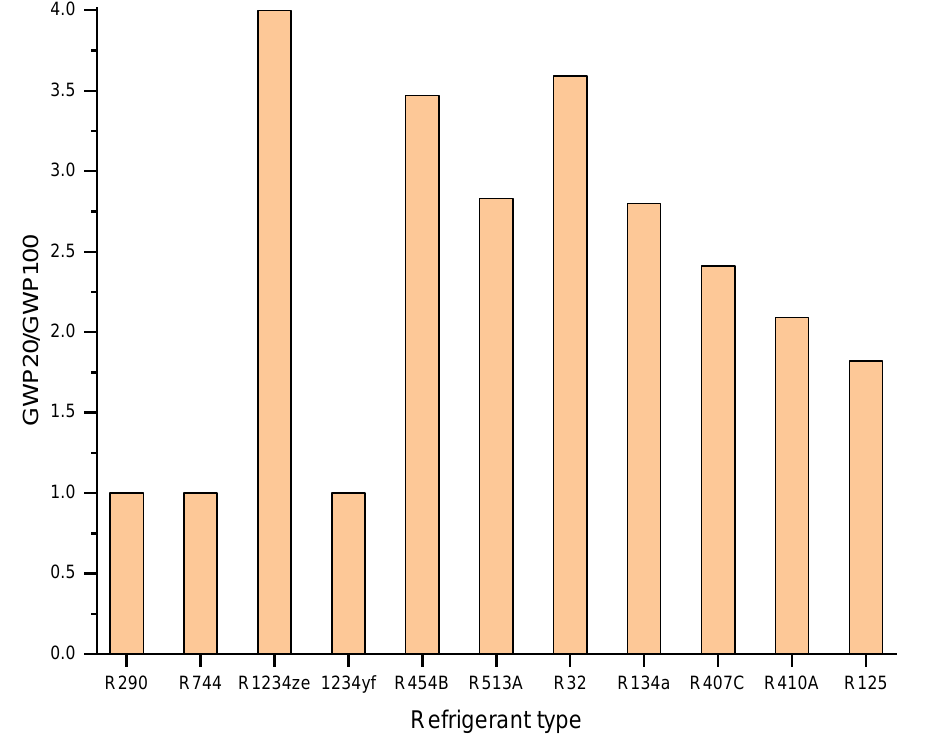
Figure 6. Relative values of GWP 20 with respect to values of GWP 100.